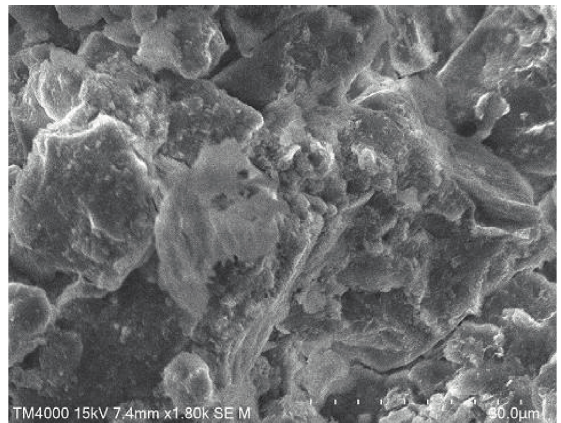
Figure 12: 6% cement +0.5‰ EFS reinforced soil (1.8k